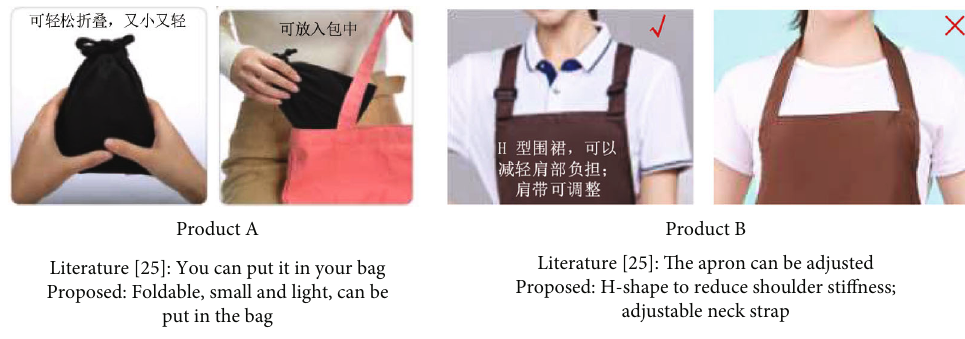
Figure 10: Comparison of recognizing multimedia image information between the proposed model and the model in literature